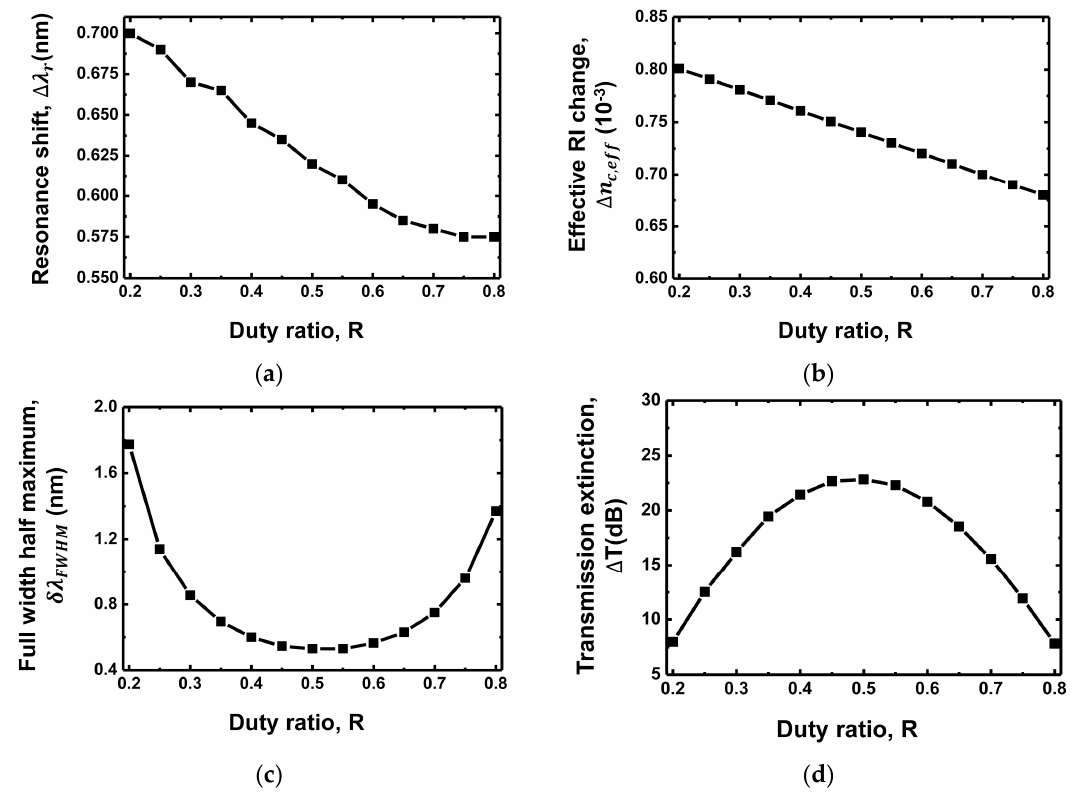
Figure 4. ( a ) Resonance shift ( ∆ λ r ); ( b ) Effective change in RI ( ∆ n ef f ); ( c ) FWHM ( δλ FWHM ); ( d ) Transmission extinction ( ∆ T) as functions of the duty ratio of the grating